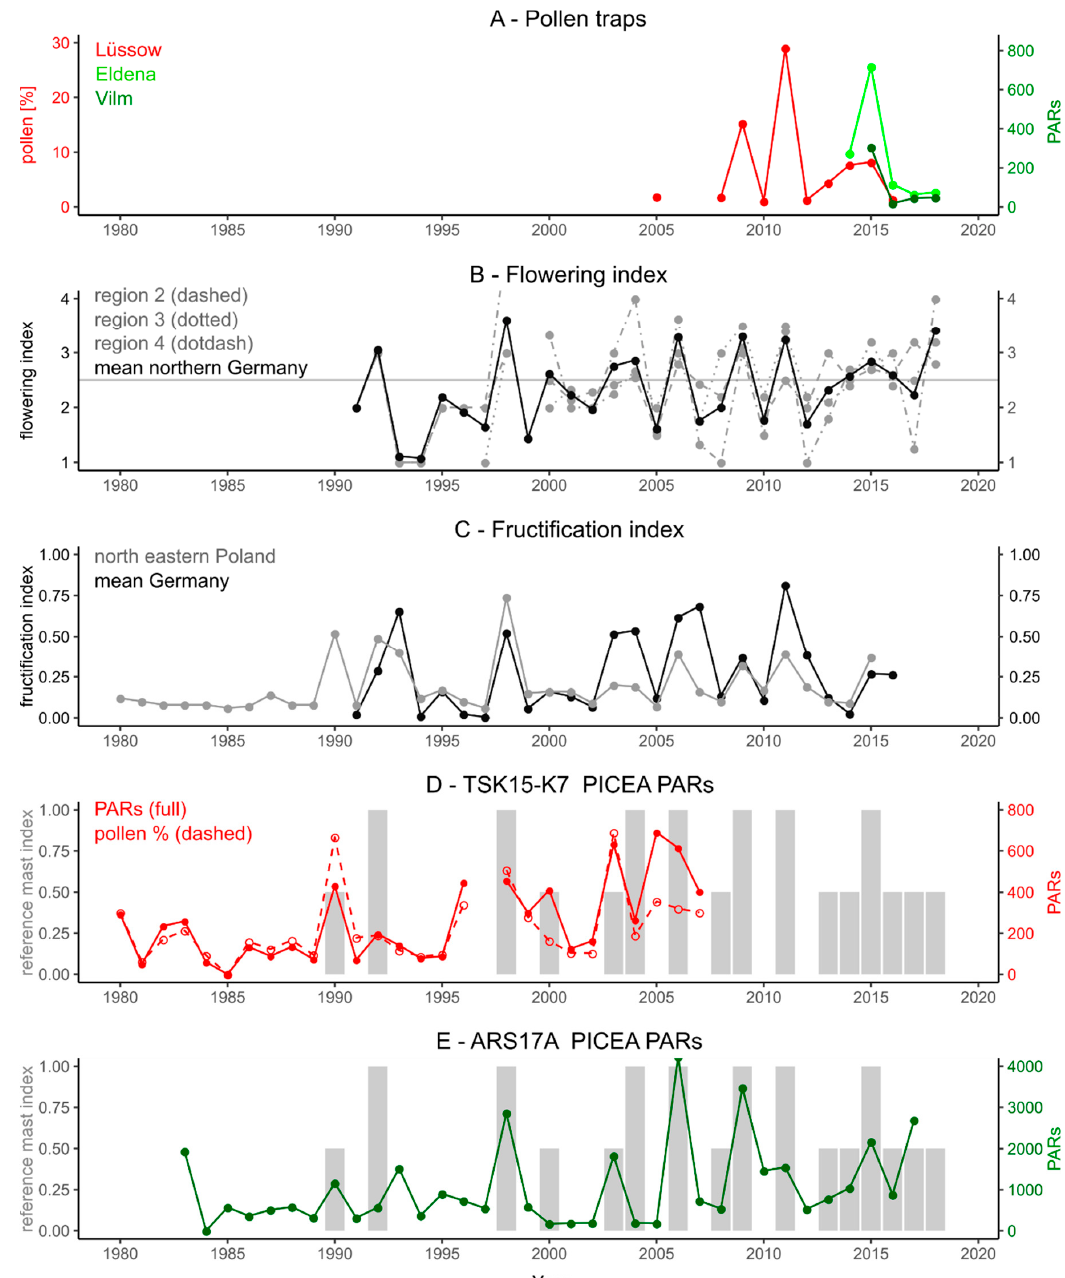
Figure 4. Pollen and forest monitoring data for spruce ( A – C ), annual pollen deposition in three sediment cores ( D – E ). Grey bars: Long bars indicate supposed intense, short bars intermediate flowering